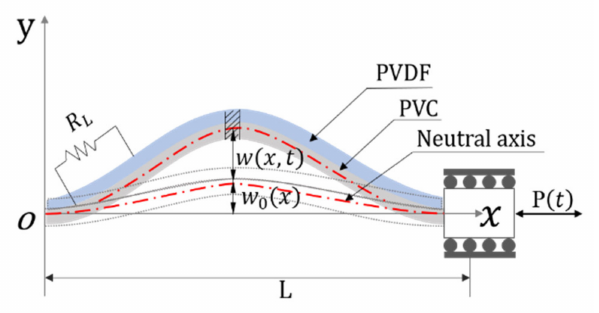
Figure 1. Schematic diagram of the doubly clamped piezoelectric energy harvester. In the beam model, the origin is set at the centroid of the left end. The y -axis is set upward along the thickness, and the x -axis is set to the right direction along the neutral plane. Assuming that the central principal inertia axis of every beam element section is in xy plane, the piezoelectric beam is pre-compressed with an initial deflection, which is represented by w 0 ( x ). According to D’Alembert’s principle, it is supposed that forces in the finite beam element acting at point C . As shown in Figure 2, the external load is applied horizontally so that the beam is buckled to induce transverse